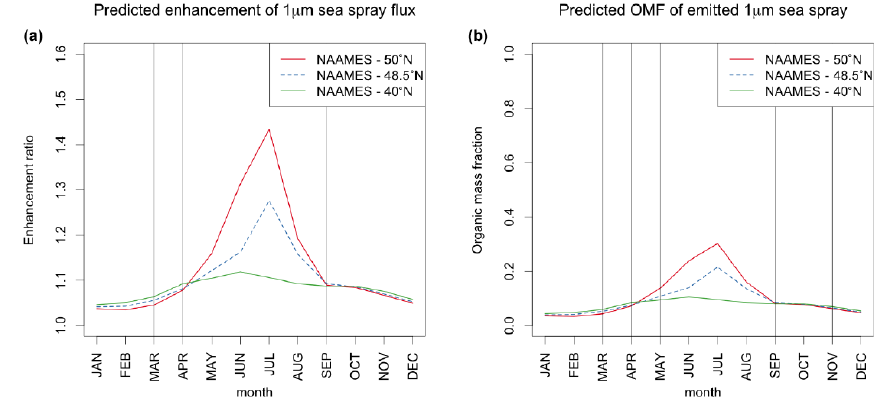
Figure 6. OCEANFILMS-predicted seasonal cycle of biological enhancement in the emission flux ( a ; ratio of predicted MOA+sea salt flux to flux of pure sea salt) and the organic mass fraction (b) of sea spray particles with d < 1µm, for the region of the NAAMES field campaign. The NAAMES campaign consisted of four cruises in different seasons, with most scientific sampling occurring close to 40 ◦ W and between approximately 40 and 50 ◦ N (Behrenfeld et al., 2019). All model results are monthly mean output at 40 ◦ W and at the latitudes indicated in the legend. Vertical lines indicate the months during which each variable was measured by NAAMES.